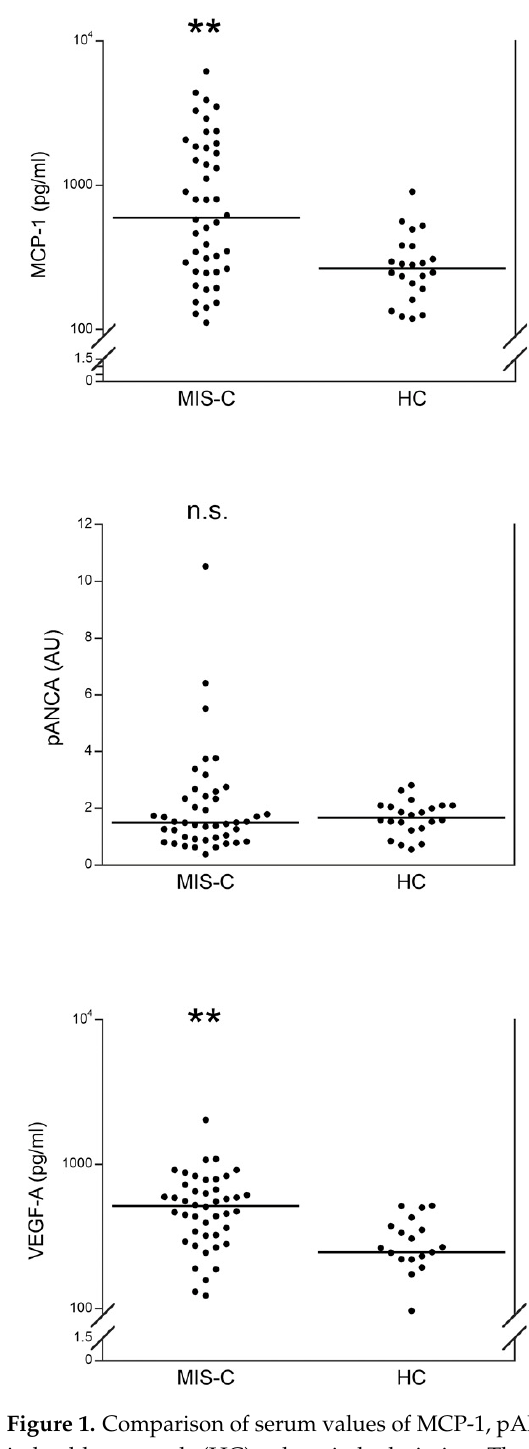
Figure 1. Comparison of serum values of MCP-1, pANCA, and VEGF-A in patients with MIS-C and in healthy controls (HC) at hospital admission. The line represents the median value. * p < 0.01; ** p < 0.001; n.s.: not significant. Table 1. Spearman correlation analysis in MIS-C patients.